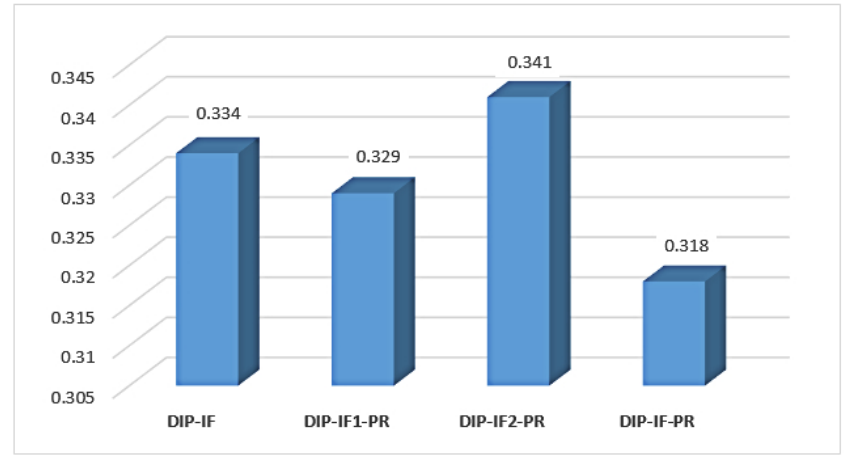
Figure 5. The average LPIPS scores of the models with different settings on a “chicken” image with 60%, 70%, and 80% noise corruptions. Note that a smaller value of LPIPS implies a better result in denoising.